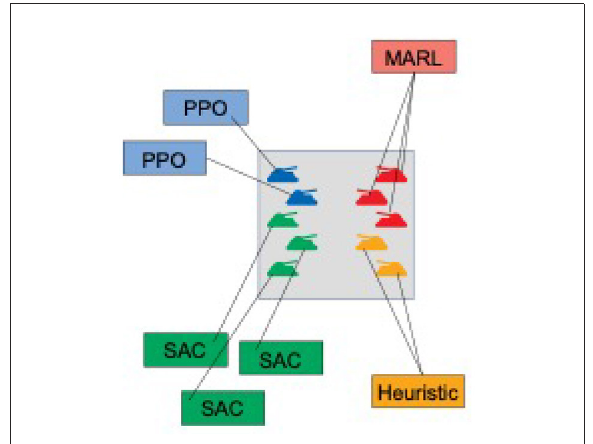
FIGURE1 Simultaneous multi-agent multi-strategy policy learning. The figure illustrates an example multi-agent setting where the policies of individual agents are learned simultaneously with different learning